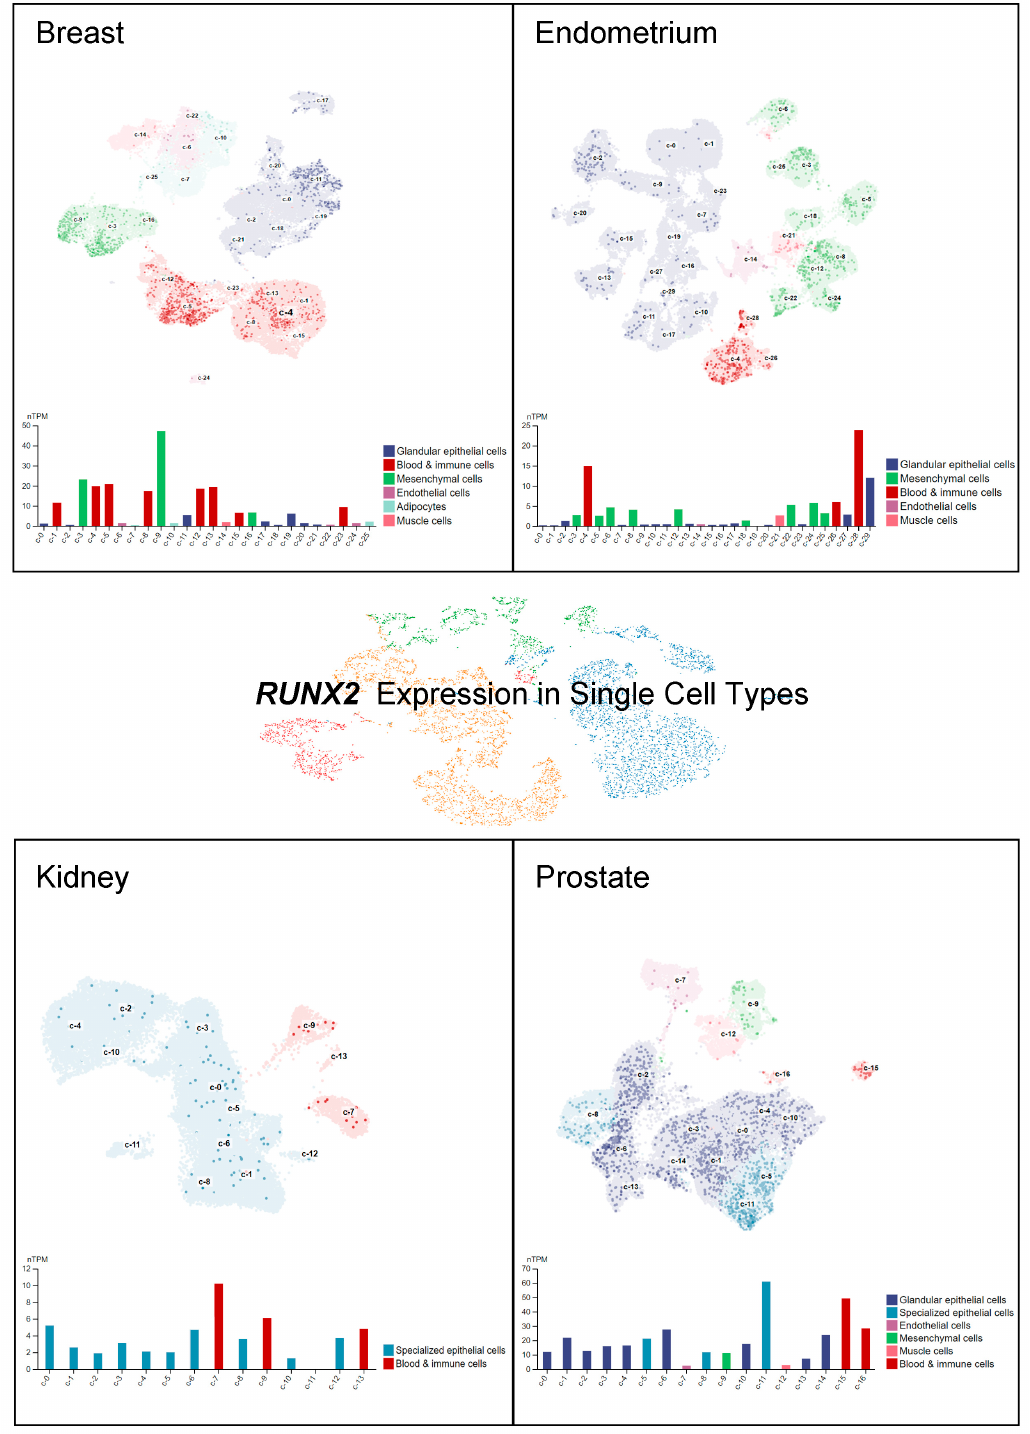
Figure 3. Human RUNX2 RNA distribution in single cells across different cell types. The RUNX2 level was measured by scRNA-seq in different tissues. The RNA expression levels are visualized at the single-cell level by UMAP plot. Data were adapted with permission from HPA (https://www.proteinatlas.org/about/licence#citation_guidelines_for_the_human_protein_ atlas, accessed on: 21 February